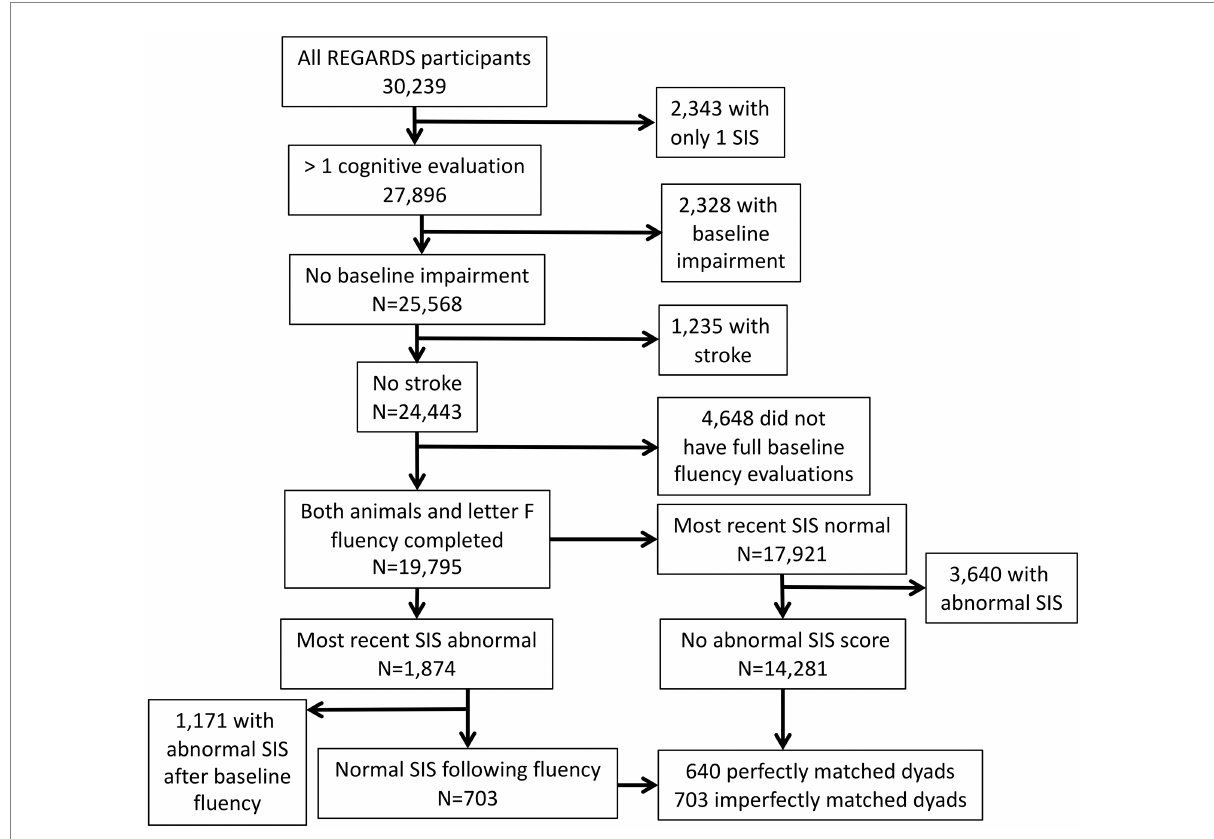
FIGURE 1 Flow chart depicting participant selection. Individuals were considered for the case group only if SIS scores were normal prior to recording the fluency tasks and at the first SIS follow-up after the fluency recording. This stipulation ensures that SIS performance was normal at the time of the fluency